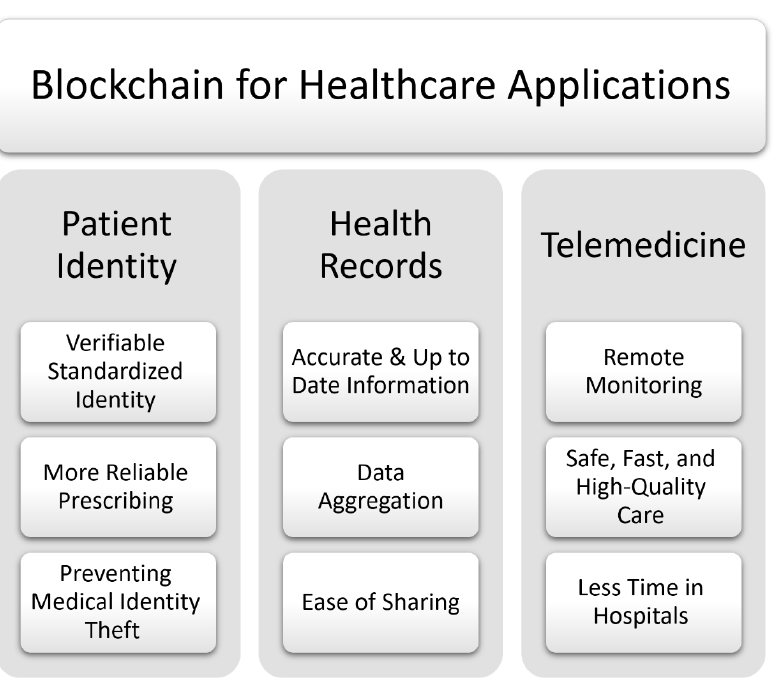
Figure 4. Blockchain for